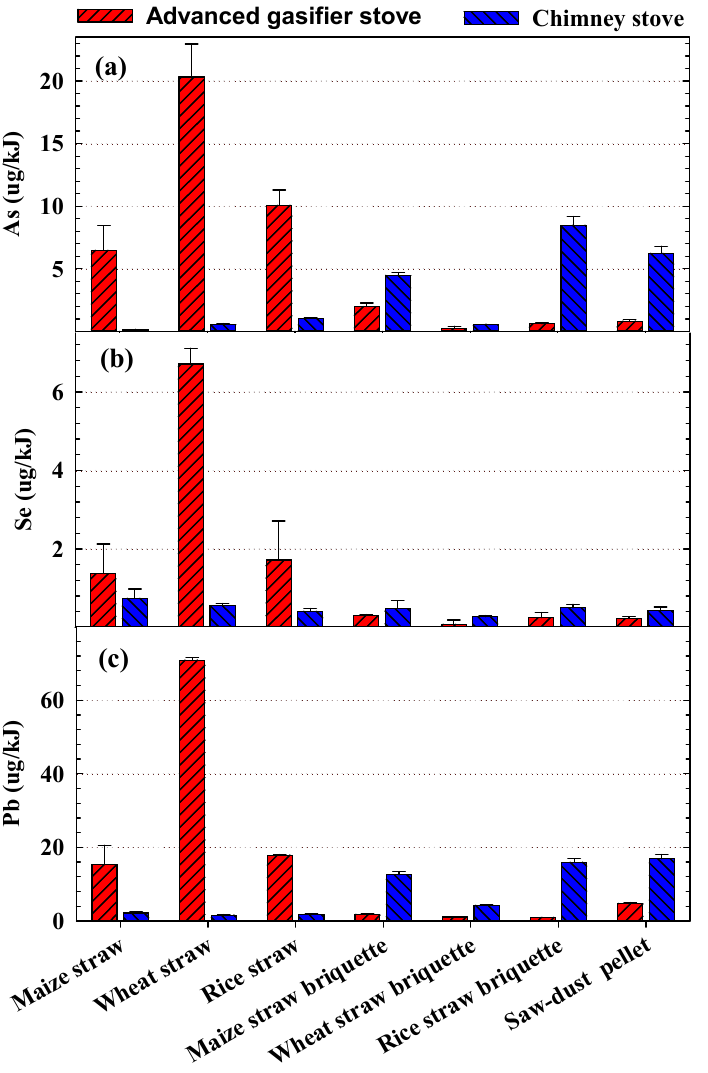
Figure 5. Toxic element EFs of raw crop straw, biomass briquettes, and pellets burned in the advanced biomass gasifier cooking stove and the chimney cooking stove: ( a ) As, ( b ) Se, and ( c ) Pb.